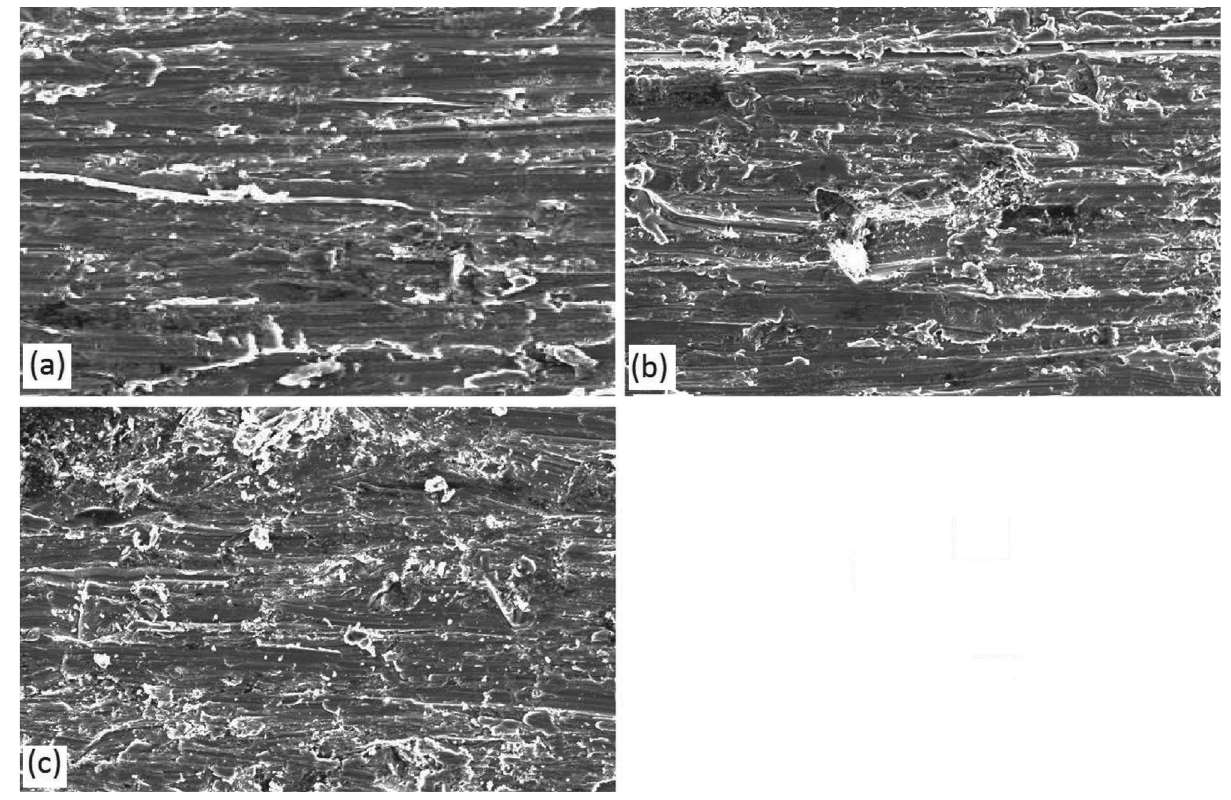
Fig. 14: SEM images of the worn surfaces at 3% reinforcement volume ratio composites manufactured at 800 °C temperature and 500 rev/ min stirring speed, (a) 150 mesh, (b) 240 mesh and (c) 320